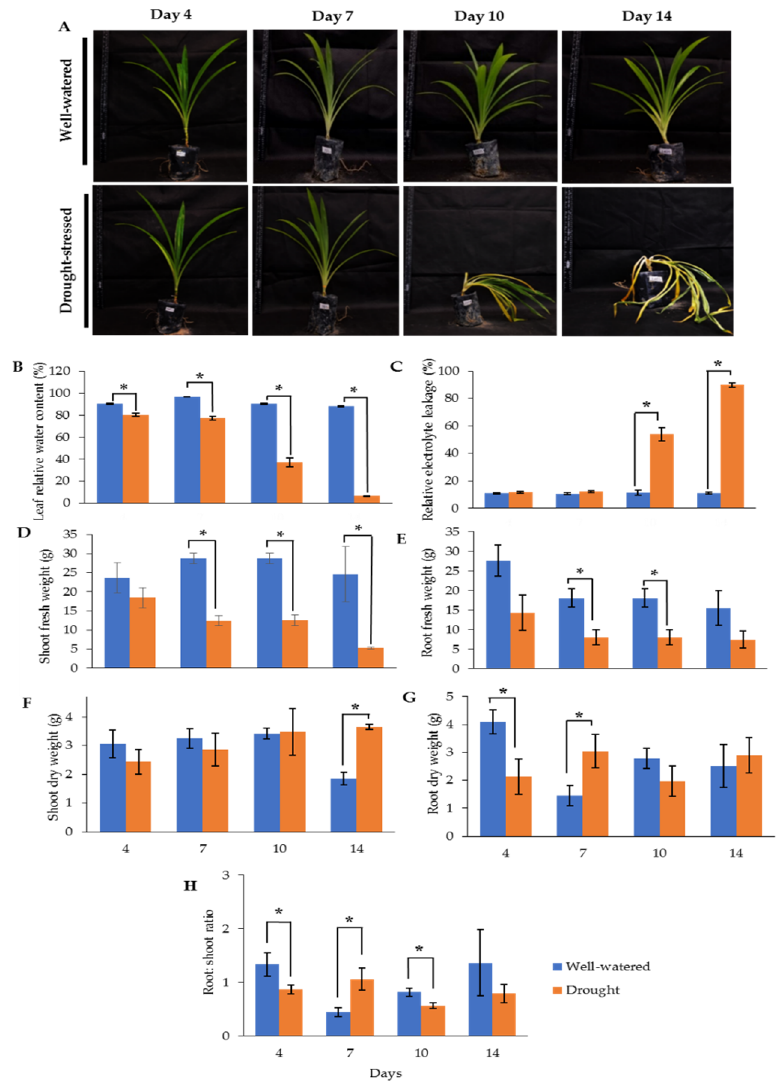
Figure 1. Responses of drought-stressed and well-watered Pandanus amaryllifolius . P. amaryllifolius plants were subjected to drought stress by withholding water for 4, 7, 10, and 14 days. Well-watered P. amaryllifolius was served as control. ( A ) Photographs of Pandanus plants were taken at 4, 7, 10, and 14 days. ( B ) The percentage of LRWC of P. amaryllifolius leaves at different time points. ( C ) The percentage of REL for each sample at different harvest points. ( D ) Shoot fresh weight of Pandanus . ( E ) Root fresh weight of Pandanus . ( F ) Shoot dry weight of Pandanus . ( G ) Root fresh weight of Pandanus . ( H ) Root-to-shoot ratio of Pandanus dry weight. Means labeled with asterisk were significantly different based on the Student’s t -test when its p -value < 0.01.